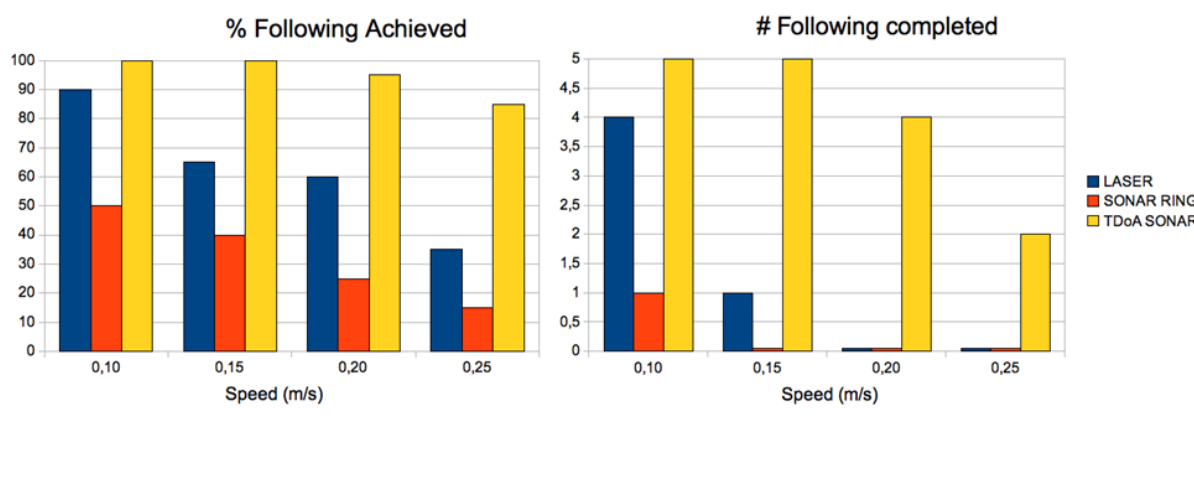
Figure 11. Comparative Results. % Follow. achieved (left). # Follow. completed